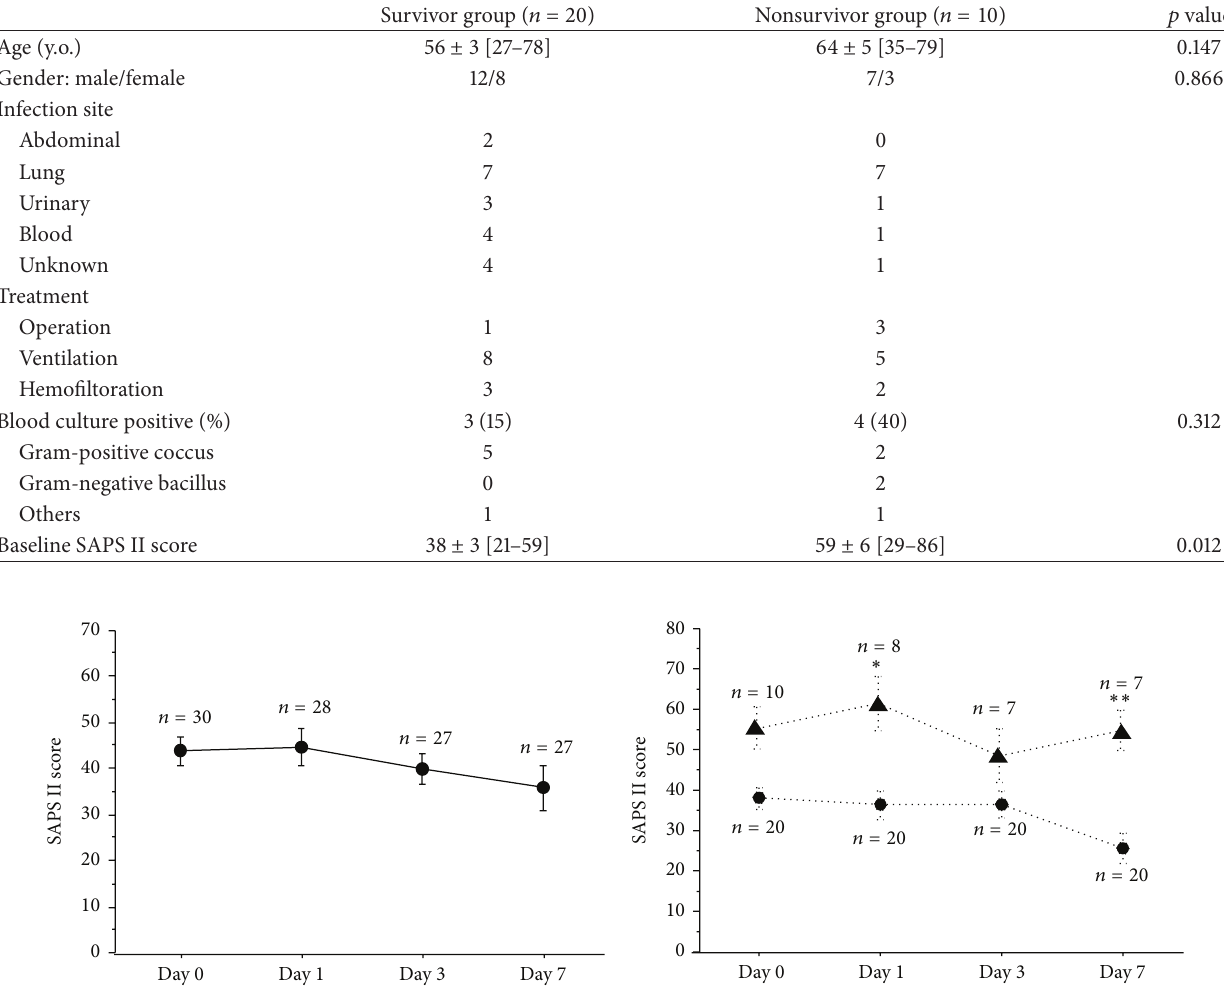
Table 1: Patient demographics.